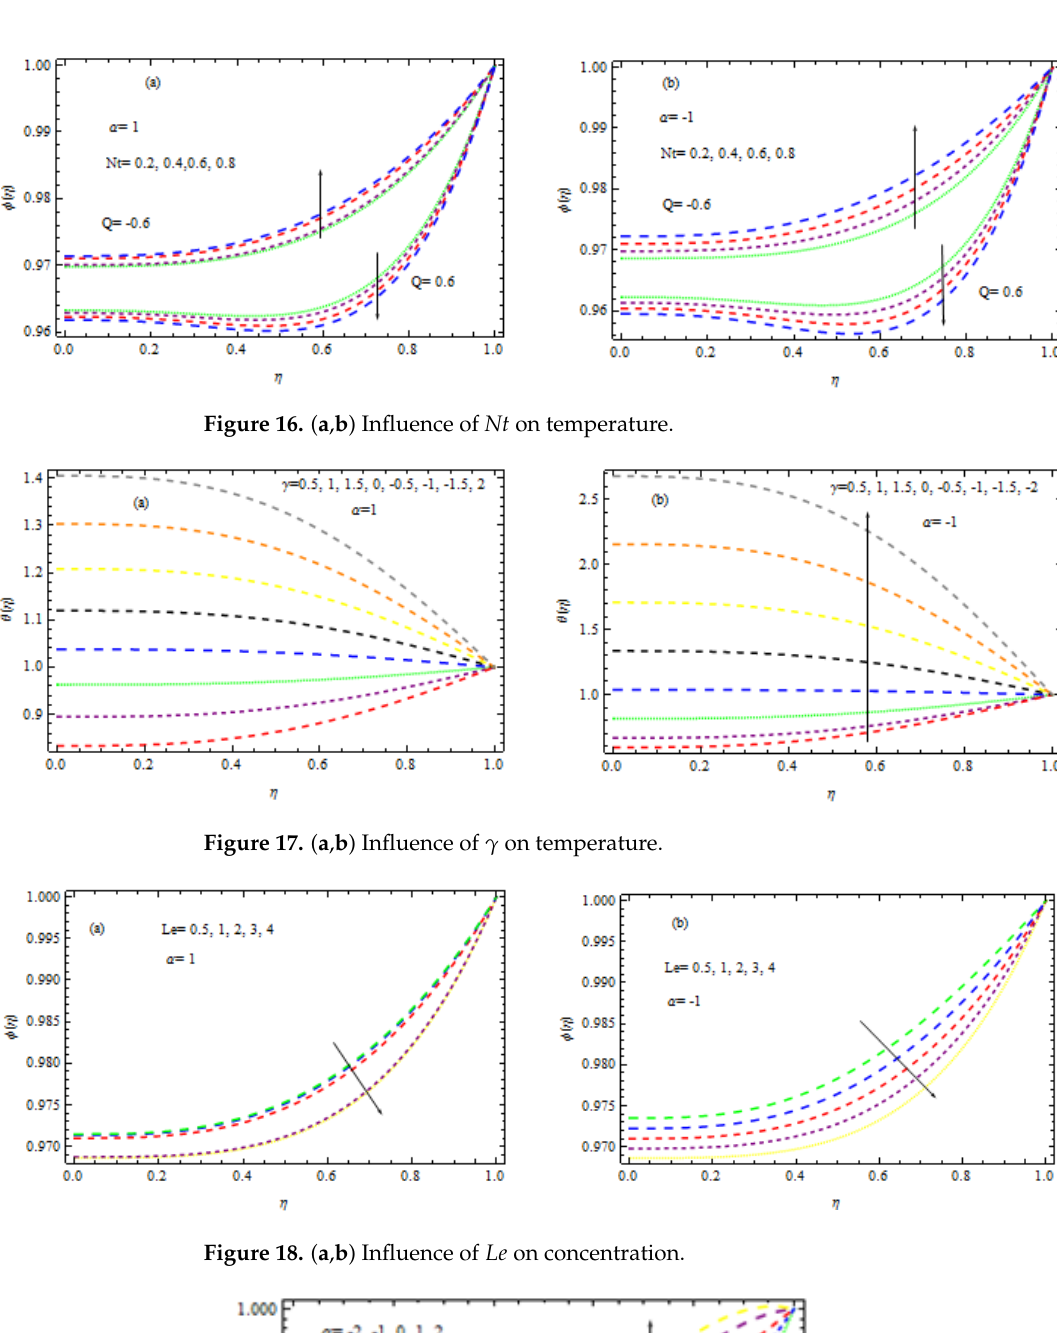
Figure 15. ( a , b ) Influence of Nb on temperature.